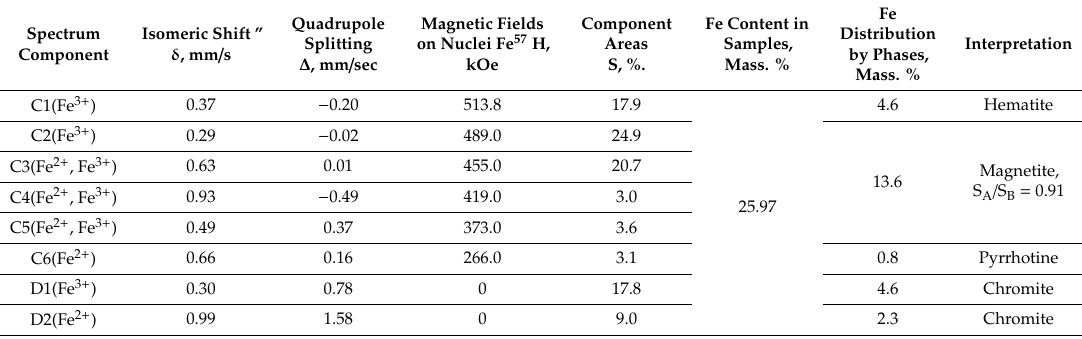
Figure 8. Mössbauer spectrum of the magnetic phase of the upper soil horizon of the Urbic Technosol Loamic, Eutric in the residential part of Gubakha (subzone D). Table 9. Mössbauer parameters of the sample of the magnetic phase of the upper soil horizon of the Urbic Technosol Loamic, Eutric (subzone D).